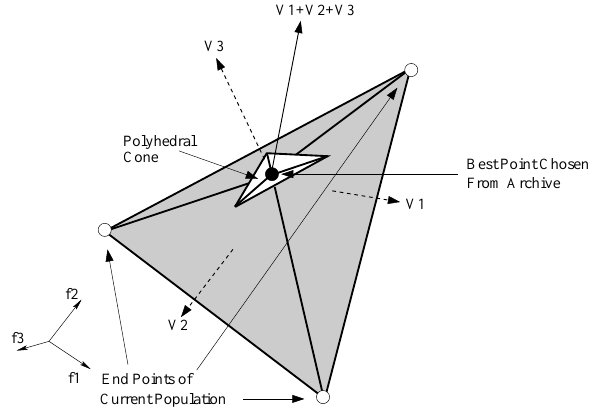
Figure 16. Polyhedral cone in 3